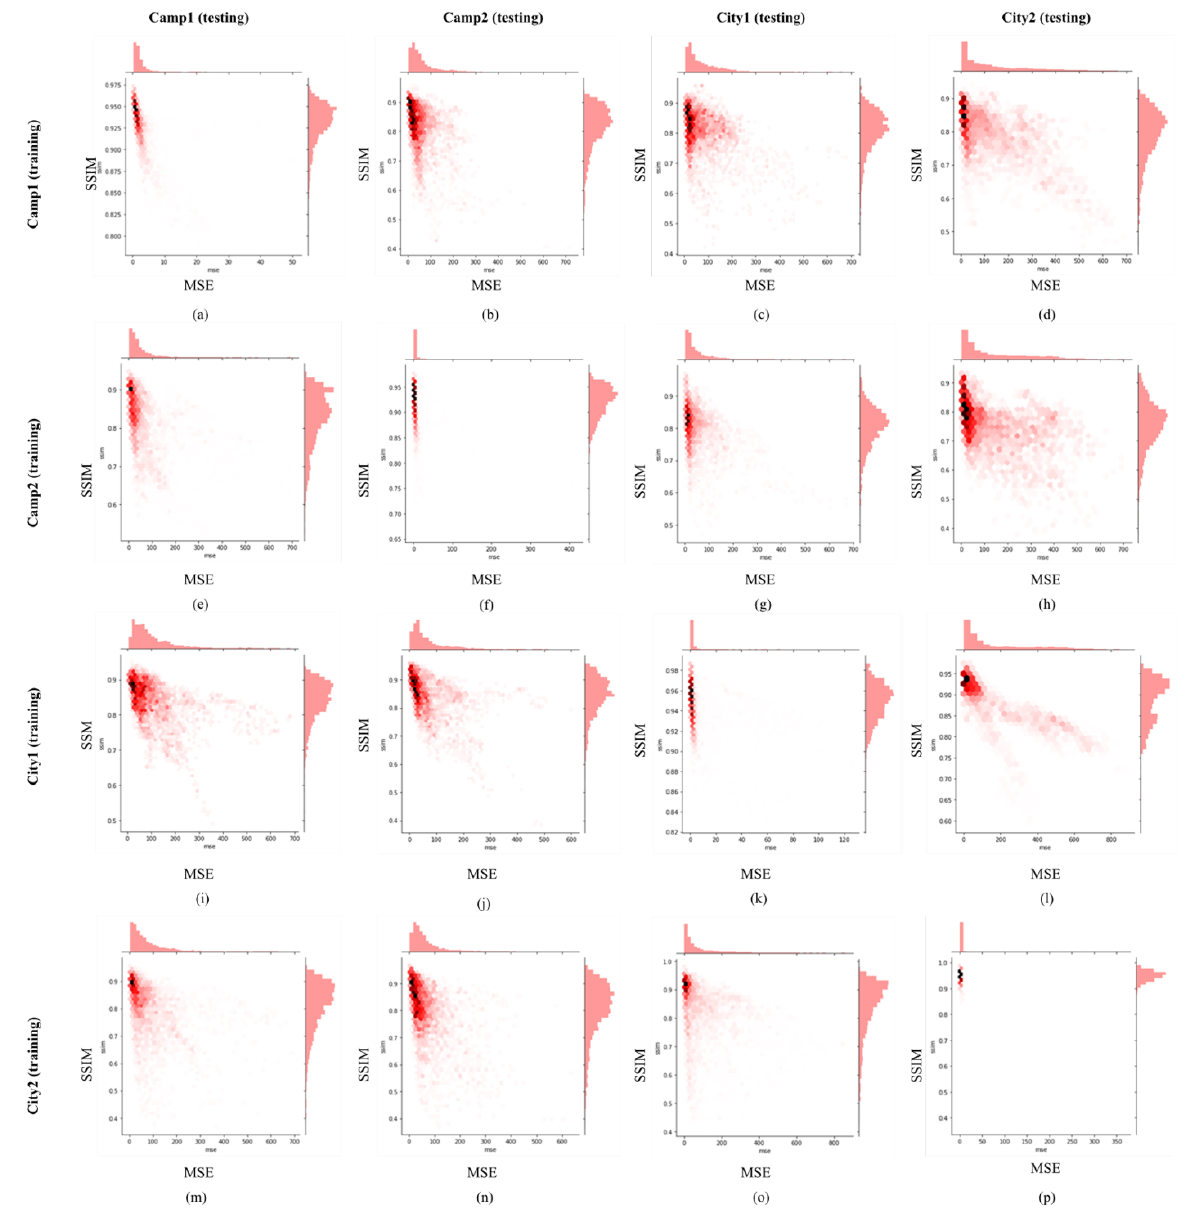
Figure 5. Multivariate distribution figures for both the same and cross-experiment evaluations. ( a ) Distribution of Camp1(training) vs. Camp1(testing), ( b ) Distribution of Camp1(training) vs. Camp2(testing), ( c ) Distribution of Camp1(training) vs. City1(testing), ( d ) Distribution of Camp1(training) vs. City2(testing), ( e ) Distribution of Camp2(training) vs. Camp1(testing), ( f ) Distribution of Camp2(training) vs. Camp2(testing), ( g ) Distribution of Camp2(training) vs. City1(testing), ( h ) Distribution of Camp2(training) vs. City2(testing), ( i ) Distribution of City1(training) vs. Camp1(testing), ( j ) Distribution of City1(training) vs. Camp2(testing), ( k ) Distribution of City1(training) vs. City1(testing), ( l ) Distribution of City1(training) vs. City2(testing), ( m ) Distribution of City2(training) vs. Camp1(testing), ( n ) Distribution of City2(training) vs. Camp2(testing), ( o ) Distribution of City2(training) vs. City1(testing), ( p ) Distribution of City2(training) vs. City2(testing).